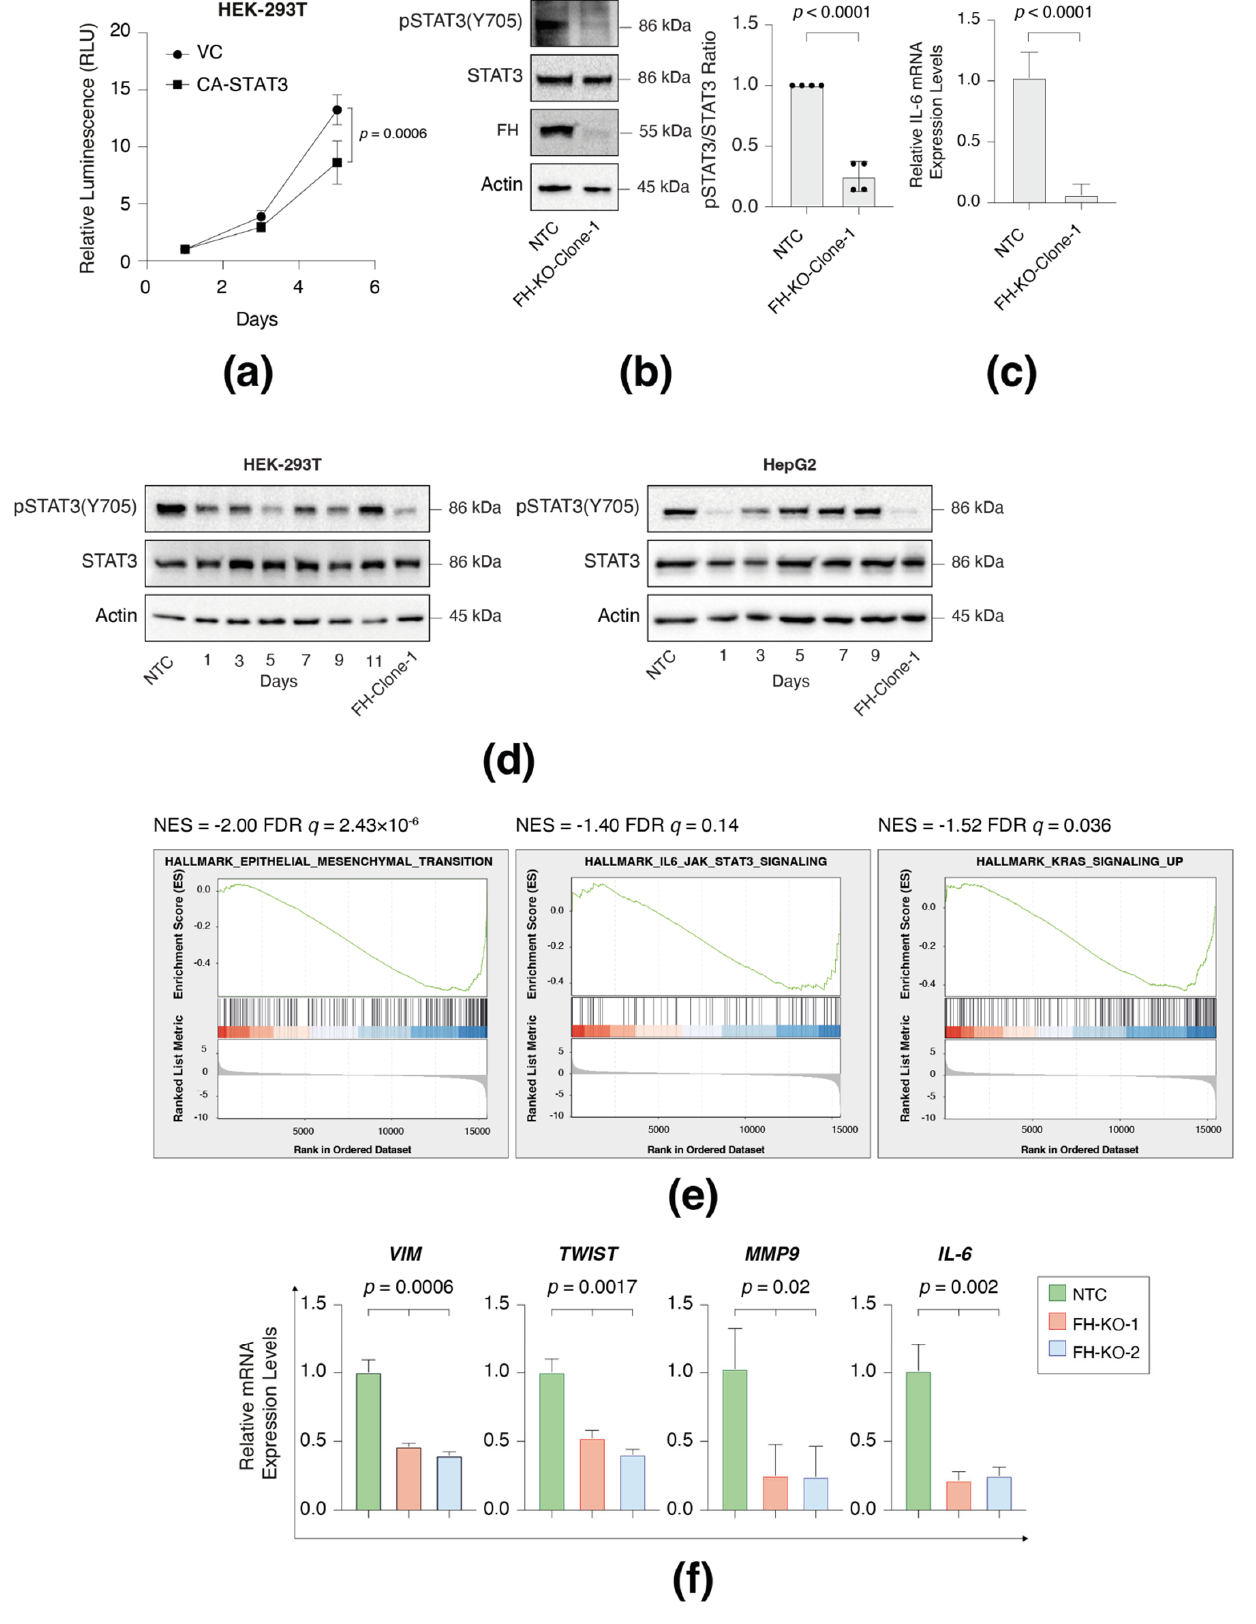
Figure 5. FH loss inhibits STAT3 signaling. ( a ) Constitutively activated STAT3 (CA-STAT3) inhibits cell proliferation in HEK-293T. The proliferation rates of WT and CA-STAT3 cells were measured